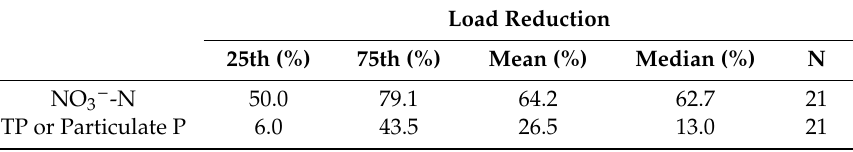
Figure 7. Increase in nitrate-N (NO 3— N) mass removed as the NO 3− -N load into the floodplain increased (y = 0.2946x + 115.67, ρ = 0.70, p = 0.004).